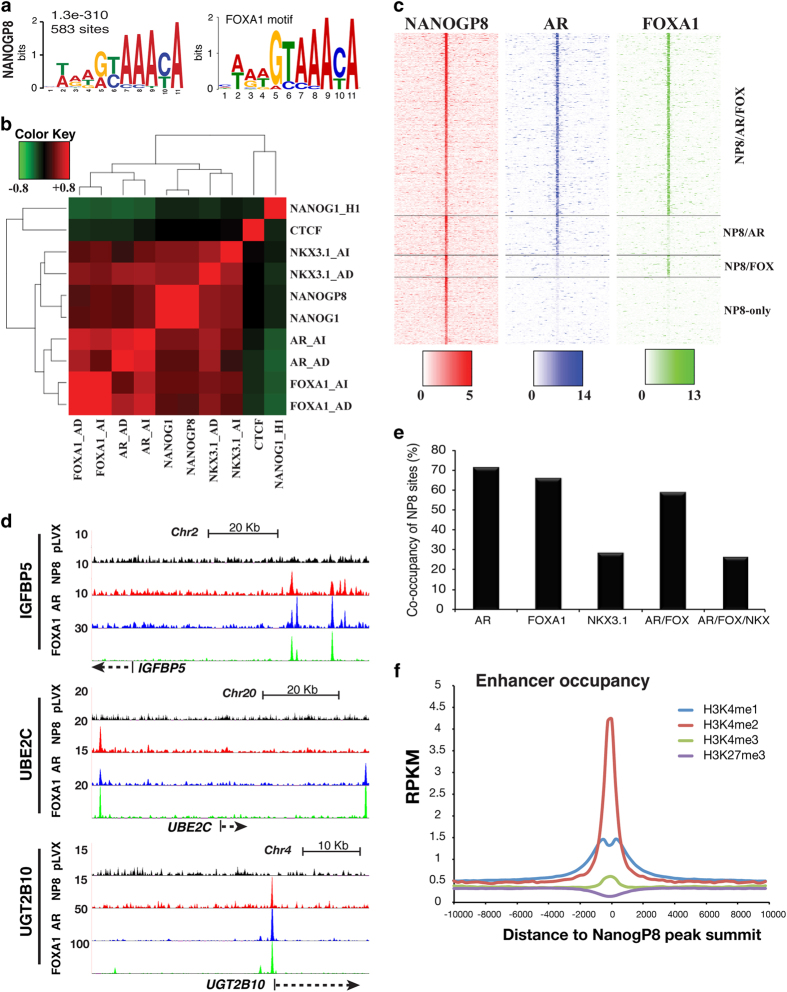
NANOG co-occupies the AR and FOXA1 sites in LNCaP cell genome. (a) MEME motif analysis identifies the FOXA1 motif (right) as the most frequently occupied motif by NP8 (the E-value for the occurrence of this motif=1.3e−310) in LNCaP cells. (b) Pearson’s correlation of transcription factor (NANOG, AR, FOXA1 and NKX3.1) chromatin occupancy in LNCaP under AD and AI conditions. CTCF occupancy in LNCaP and NANOG1 occupancy in H1 ESCs are shown for comparison. (c) Signal distribution heatmap analysis of peaks (NANOGP8, FOXA1 and AR) centered on NANOGP8, ±10 kb from the peak, sorted according to NANOG peak intensity and grouped according to classification (three-way common, two-way common and NP8 only) as indicated. (d) Representative ChIP-Seq tracings reveal multiple transcription factor loci co-occupied by NANOG. (e) Bar chart showing the proportion of NANOG-binding sites co-occupied by FOXA1, AR and/or NKX3.1 in the presence of androgen. (f) Distribution of histone marks ±10 kb around NP8 ChIP-Seq peaks occurring in non-promoter occupied regions (peaks excluded from −8 kb to +2 kb relative to a TSS). H3K4me1, H3K4me3 and H3K27me3 data were acquired by ChIP-Seq; H3K4me2 data are from published data (GSM503905). RPKM, reads per kilobase of transcript per million mapped reads.